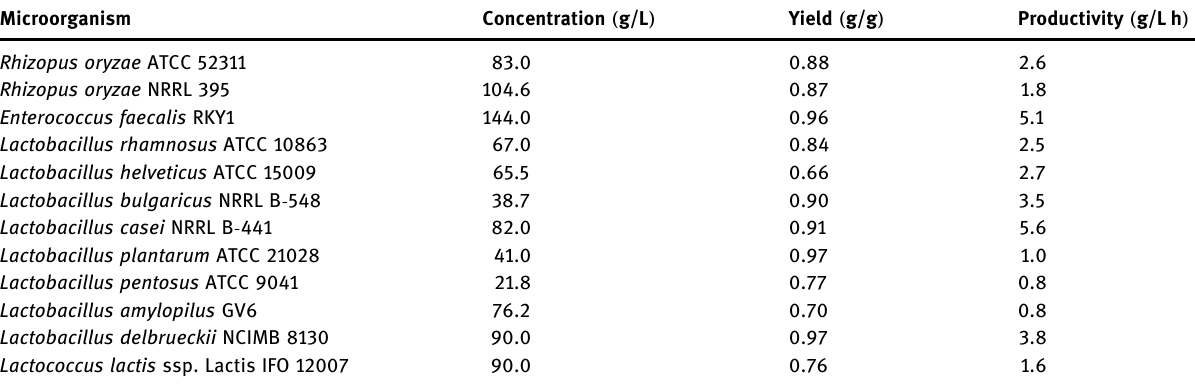
Table 1: Example of yield, productivity, and quantity of lactic acid microbial production [ 83 ]